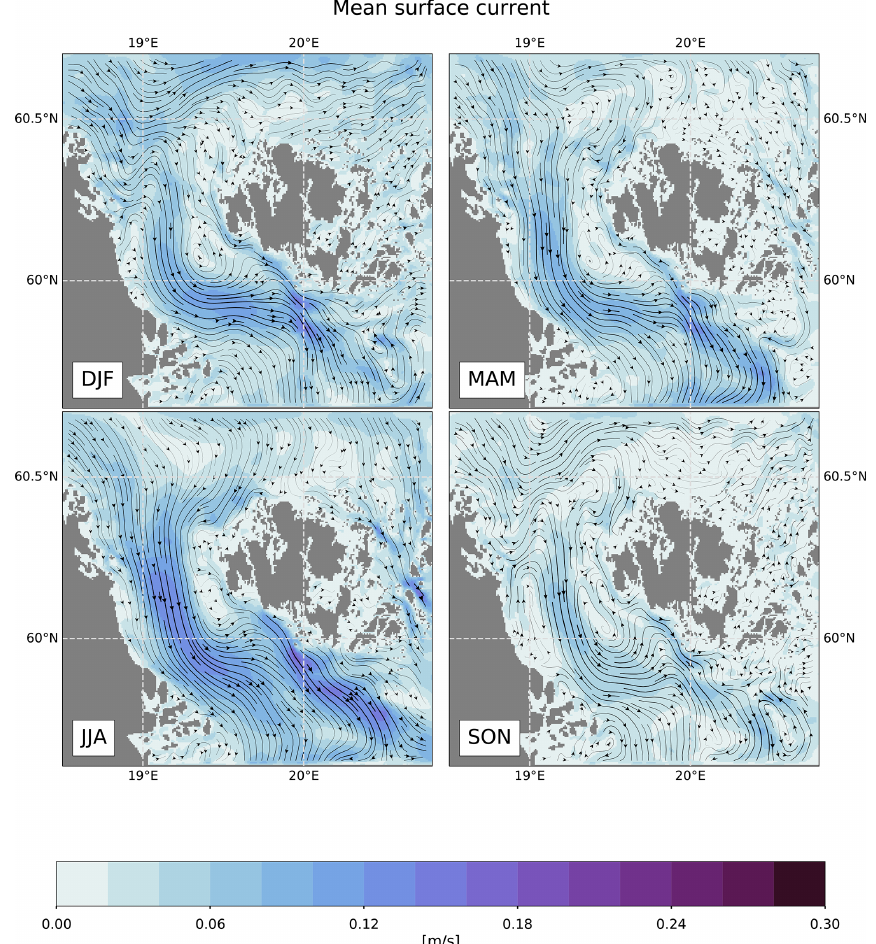
Figure 8. Seasonal means of modelled surface currents in 2013–2017. Please note that the means of current vectors are calculated as the means of elements in the vector, not as means of magnitudes. This means that in autumn (SON) when current stability is low, magnitudes of mean vectors (shown) are much smaller than means of magnitudes (not